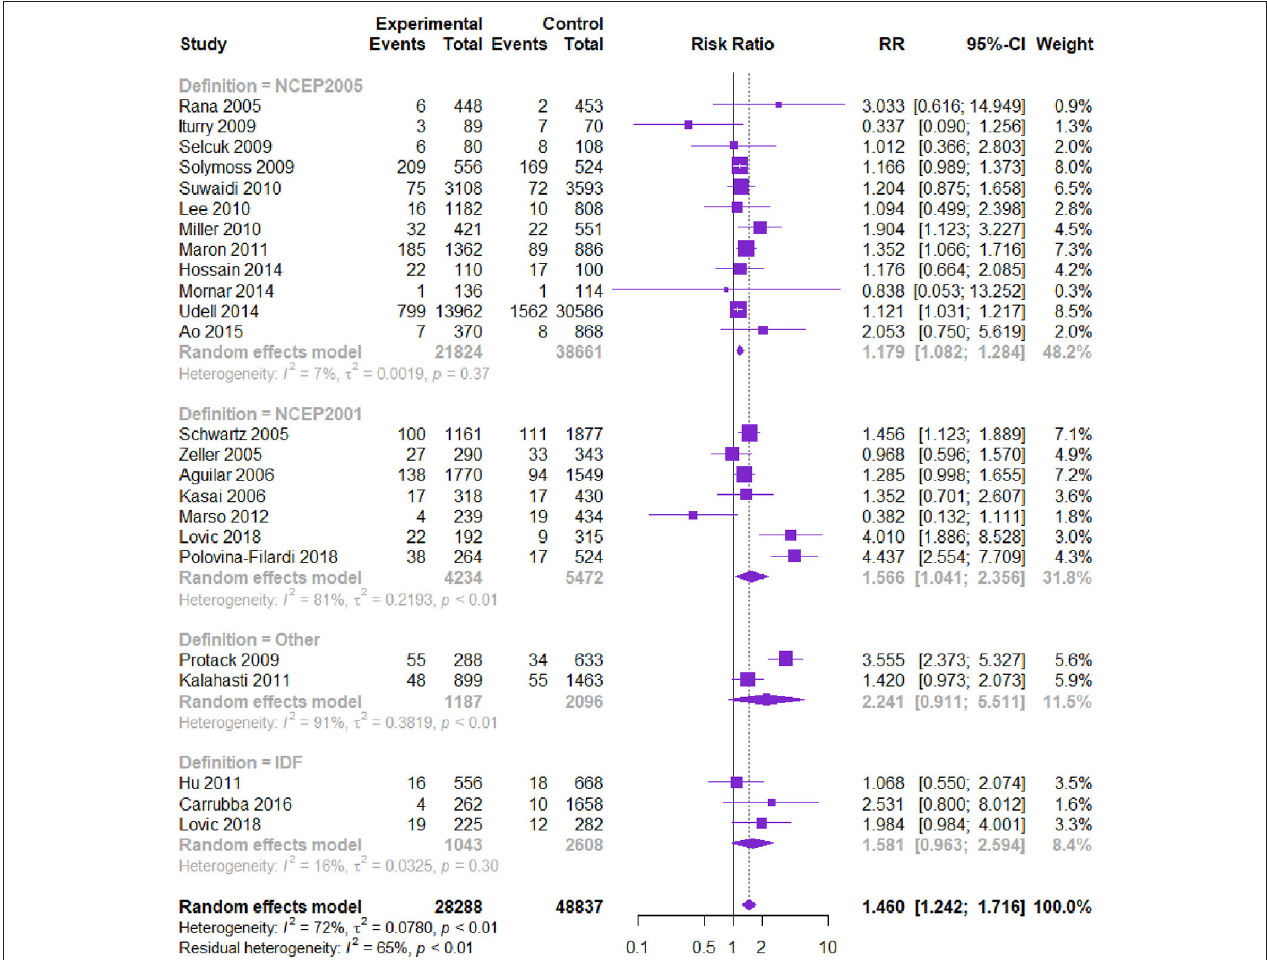
FIGURE 4 | Meta-analysis of the risk of MI in patients with CVD and MetS compared with that of patients without